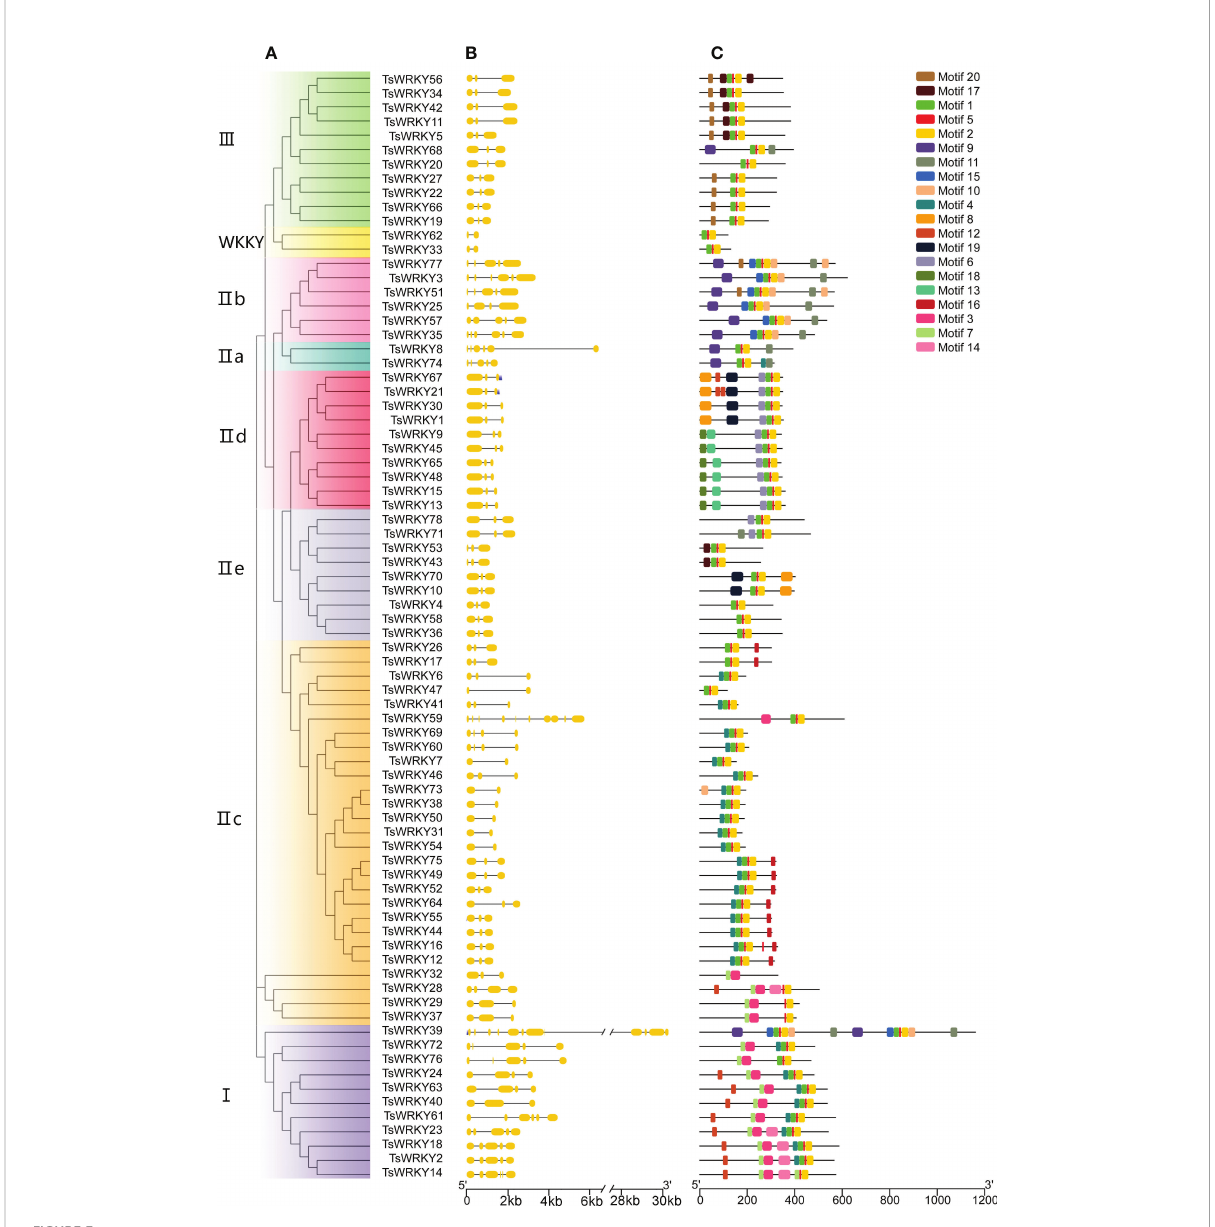
FIGURE 3 Phylogenetic tree, exon-intron distribution, and conserved protein motifs of TsWRKYs. (A) The TsWRKYs are divided into several groups, each with a distinct color. (B) Yellow rectangles and black lines represent exons and introns, respectively. (C) Each motif with conserved amino acid residues is represented in different color (motif 1 –